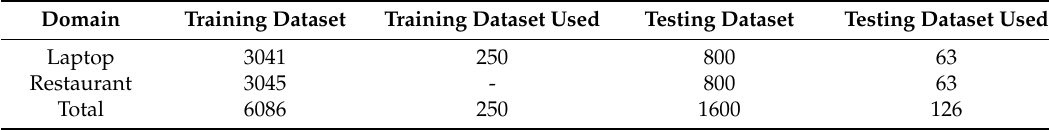
Table 12. The information of the training and testing